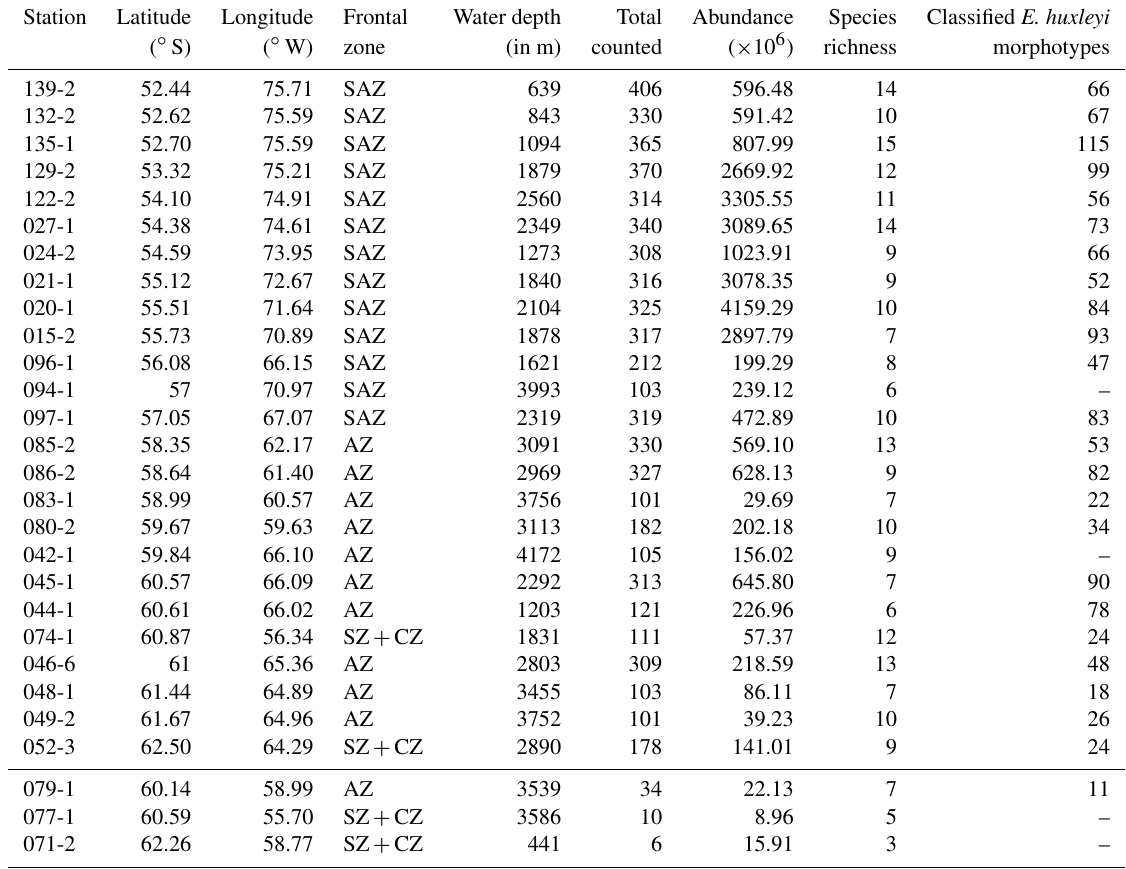
Table 2. Sample main metadata (Lamy, 2016), frontal zone, total counted coccoliths, coccolith abundance, species richness and total number of classified E. huxleyi morphotypes per sample. The lowermost three samples yielded very low total coccolith counts and were excluded from statistical analyses. Note that E. huxleyi morphotype classifications were done in an additional count (see Sect. 3)